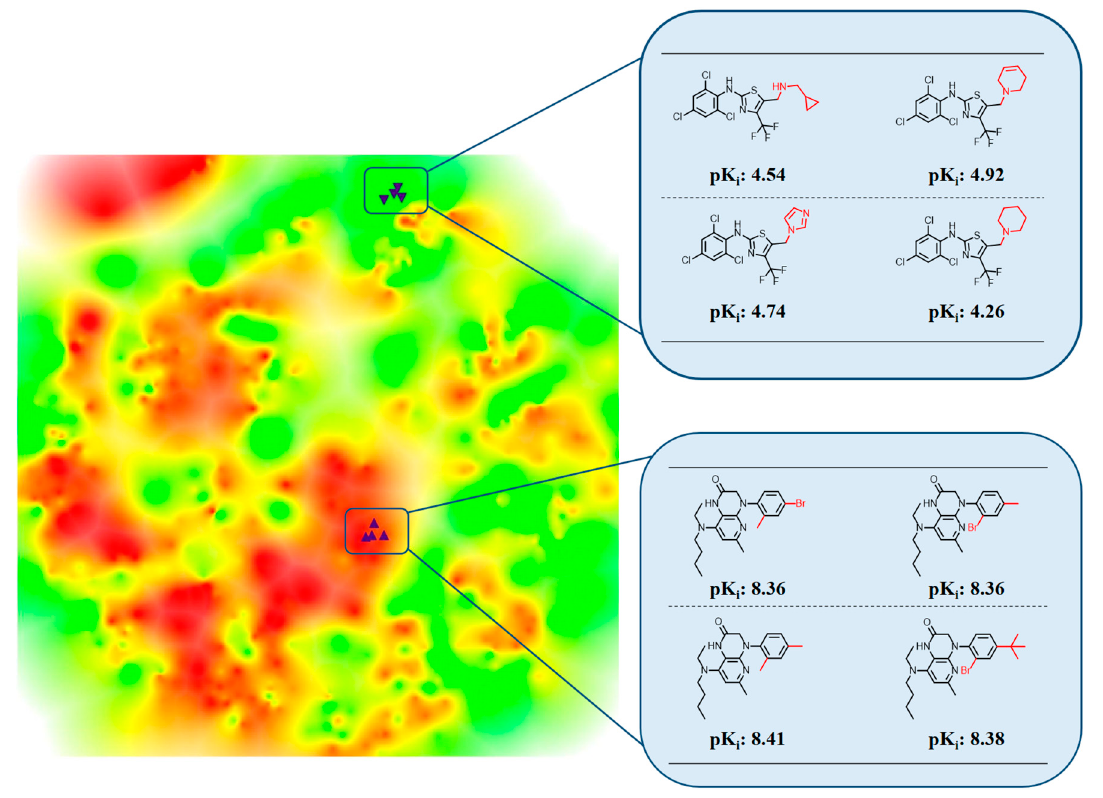
Figure 3. Heatmap with compound positions. The heatmap from Figure 2b is enlarged and positions of different compounds are indicated using black triangles. Exemplary weakly potent (top) and highly potent compounds (bottom) belong to two different analog series and map to green regions (valleys) and red regions, respectively. For each compound, its potency value is reported, and structural modifications distinguishing analogs from each series are highlighted in red.